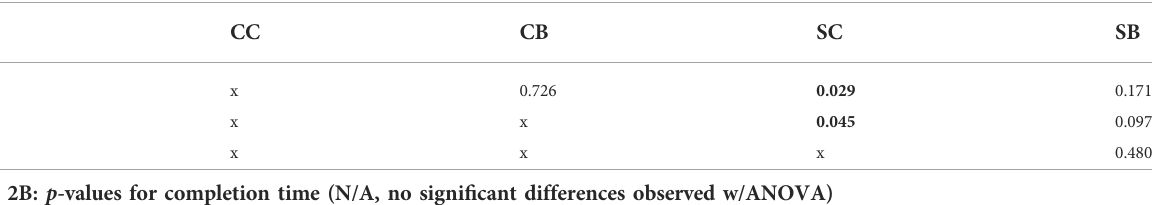
TABLE 2 Post hoc results comparing performance between pairs of visual feedback modes. Table 2A: p -values for pathlength score